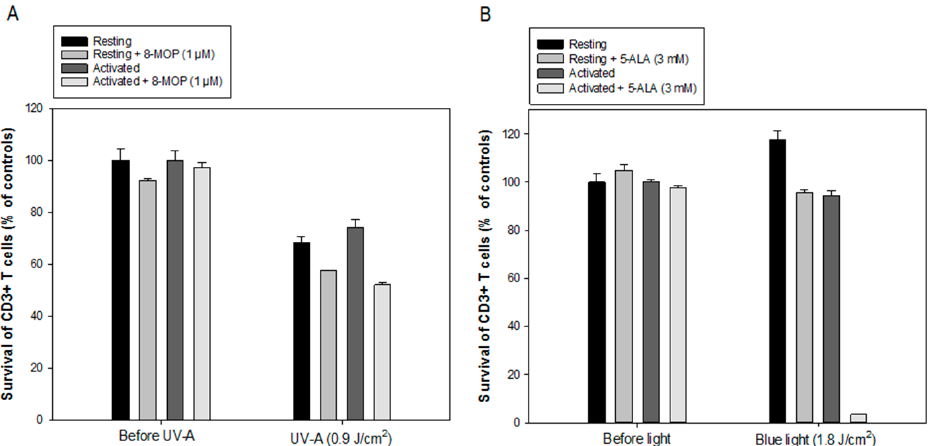
Figure 4. Comparison between ALA/Blue light and 8-MOP/UV-A. Healthy donor PBMCs were activated in vitro with anti-CD3/CD28 antibodies for three days. The resting and activated cells were incubated with ALA (3 mM) or 8-MOP (1 µ M) for 1 h in the dark at 37 ◦ C, and then exposed to the in-house built LED blue light or UV-A light. The CD3 + cell survivals were measured at 20 h after irradiation with flow cytometry using annexin-V and fixable viability dye. ( A ) Survivals of CD3 + T cells after 8-MOP / UV-A; ( B ) Survivals of CD3 + T cells after ALA-PDT.